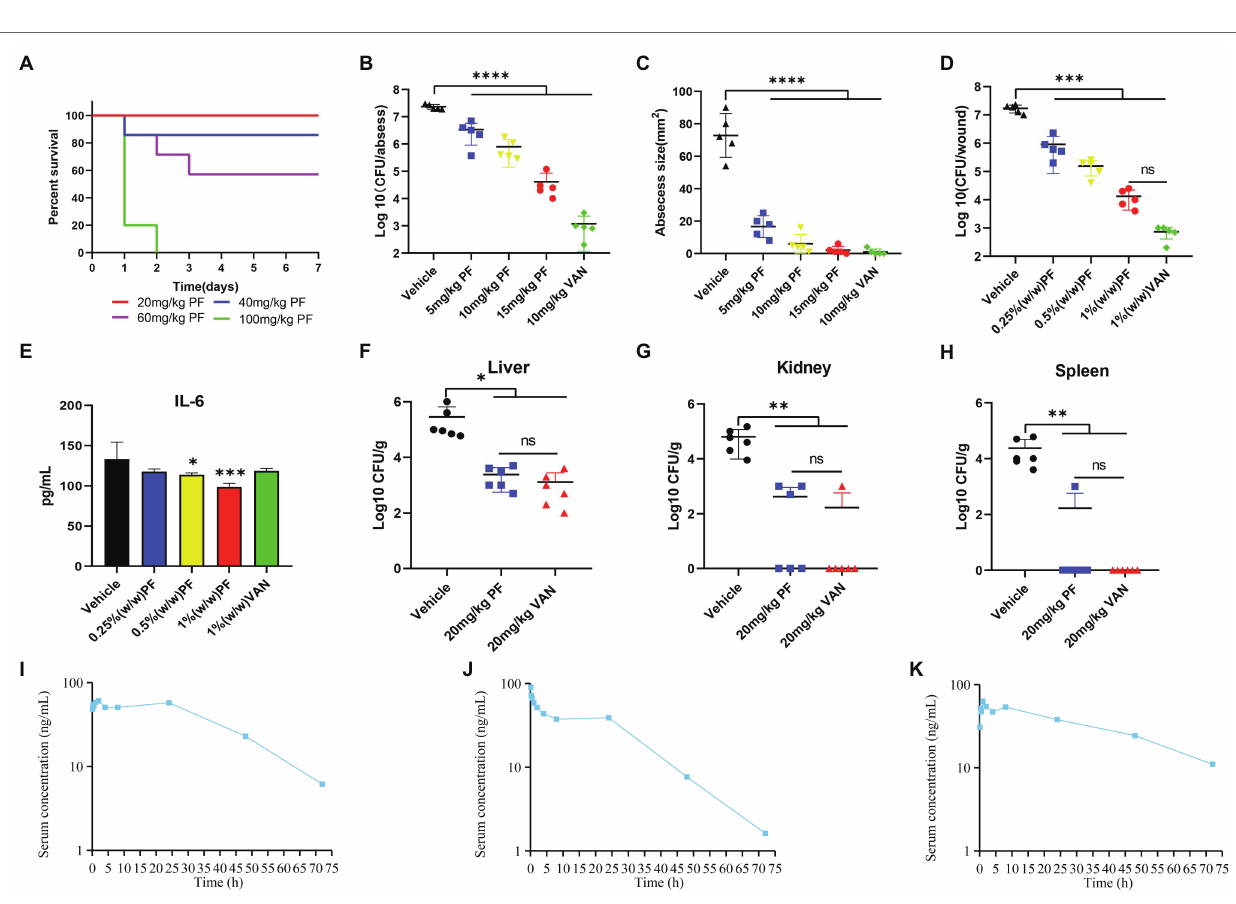
FIGURE 6 | Penfluridol displays efficacy in murine local and systemic models of infection. (A) Toxicity test in vivo ; mice ( n = 5) was intraperitoneally injected with 20, 40, 60, and 100 mg/kg PF. PF showed significant effect on reducing the (B) bacterial load and (C) abscess area in a mouse subcutaneous abscess model. Antibacterial effect of an ointment containing PF on acute wound infection model (D) wound bacterial load, and (E) cytokine IL-6 levels. The number of viable colonies in the (F) liver (G) kidney, and (H) spleen was counted in a mouse acute peritonitis model. Quantification of PF plasma concentrations in mouse blood during 72 h after (I) intravenous (J) intraperitoneal, and (K) subcutaneous administration at a dose of 10 mg/kg ( n = 4). * p < 0.05; ** p < 0.01; *** p < 0.001; **** p <